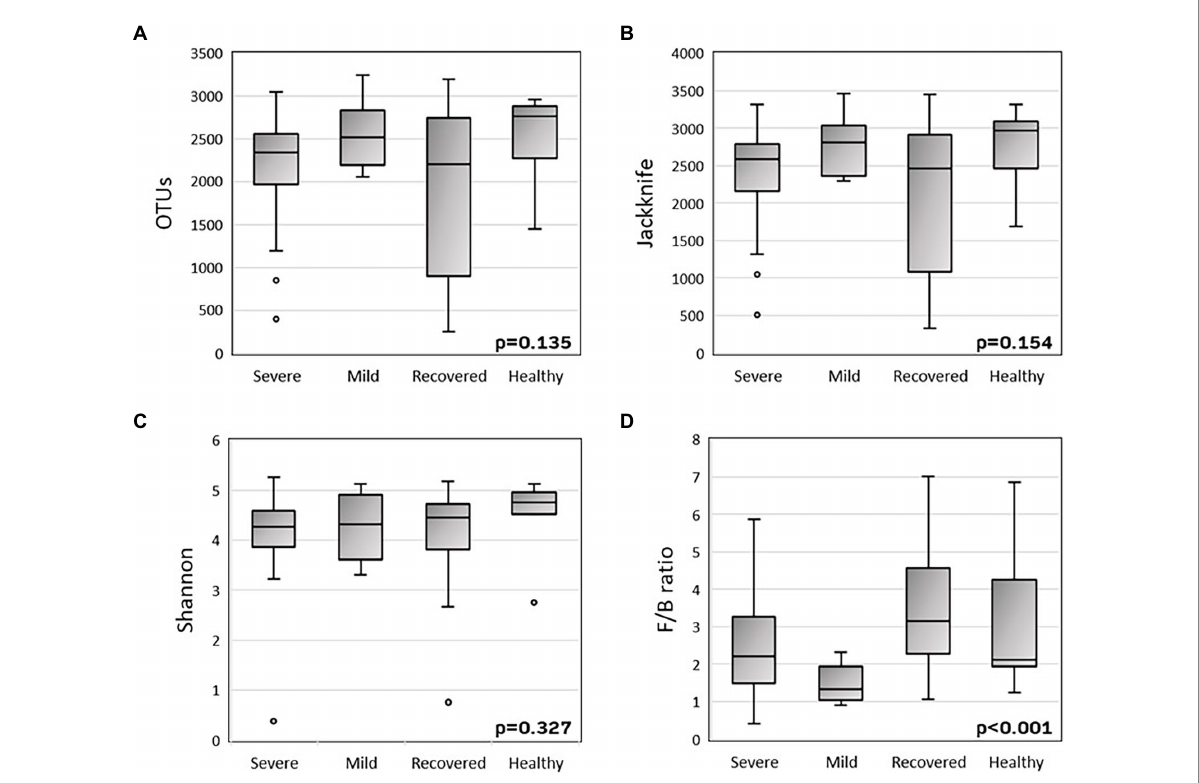
FIGURE 1 Boxplots of alpha-diversity (A-C) and Firmicutes/Bacteroidetes ratio (D) . Alpha-diversity was measured by the number of observed OTUs (A), Jackknife index (B) and Shannon index (C) . P-values were calculated with the Kruskal-Wallis test using SPSS v27.